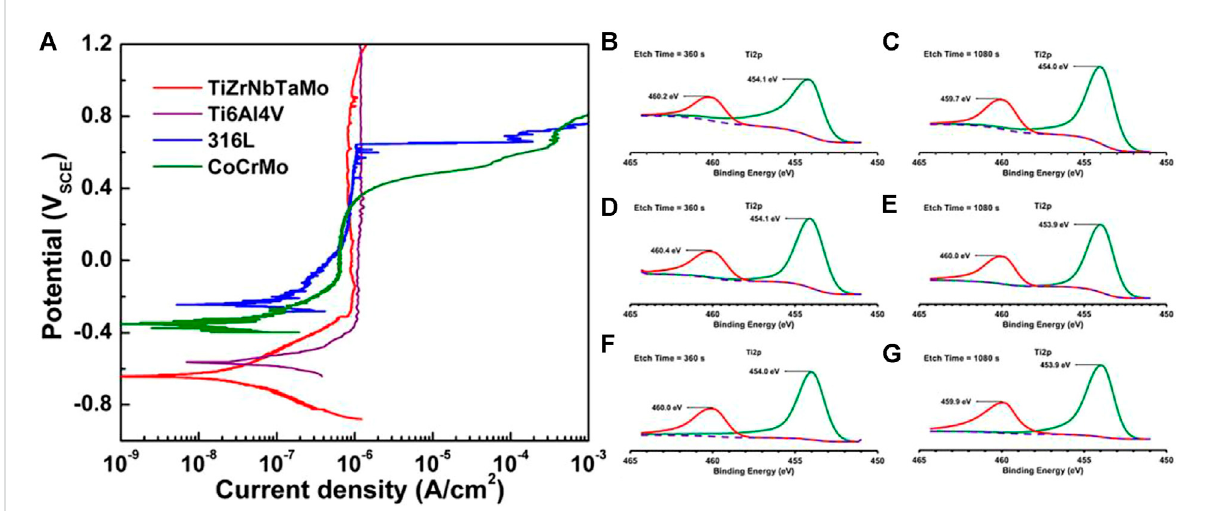
FIGURE 15 (A) Potentiodynamic polarization curves of arc-melted TiZrNbTaMo HEA, as well as Ti-6Al-4V, 316L, and CoCrMo alloys in PBS for comparison ofbiocompatibility (Wang and Xu,2017).Ti2p peaksafter etching times of 360and 1,080 simmersed inFBS for 28days: (B) and (C) for TiTaHfNb, (D) and (E) for TiTaHfNbZr, (F) and (G) for TiTaHfMoZr (Gurel et al.,